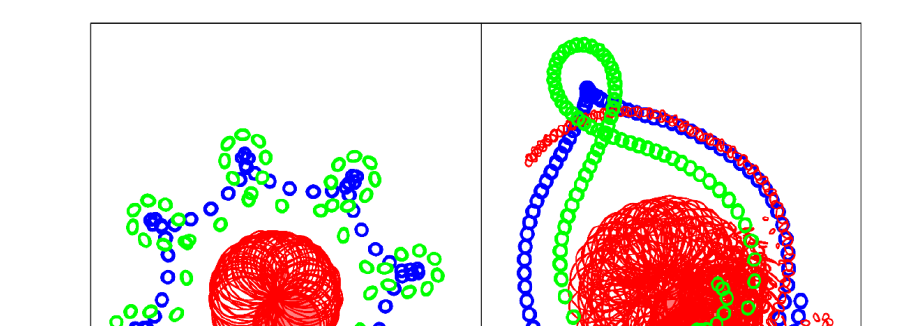
Figure 10. An intrathermocline dipole, approaching the surface cyclone at 𝑃1 = 0.6 , 𝑟 1 = 6 , 𝑟 21 = 𝑟 22 = 1 , 𝛲 21 = −𝛲 22 = 0.3, 𝑦 21 = 𝑦 22 = −16 at 𝑡 = 1, 2, …, 12: ( a ) 𝐿 = 1, ( b ) 𝐿 = 6.